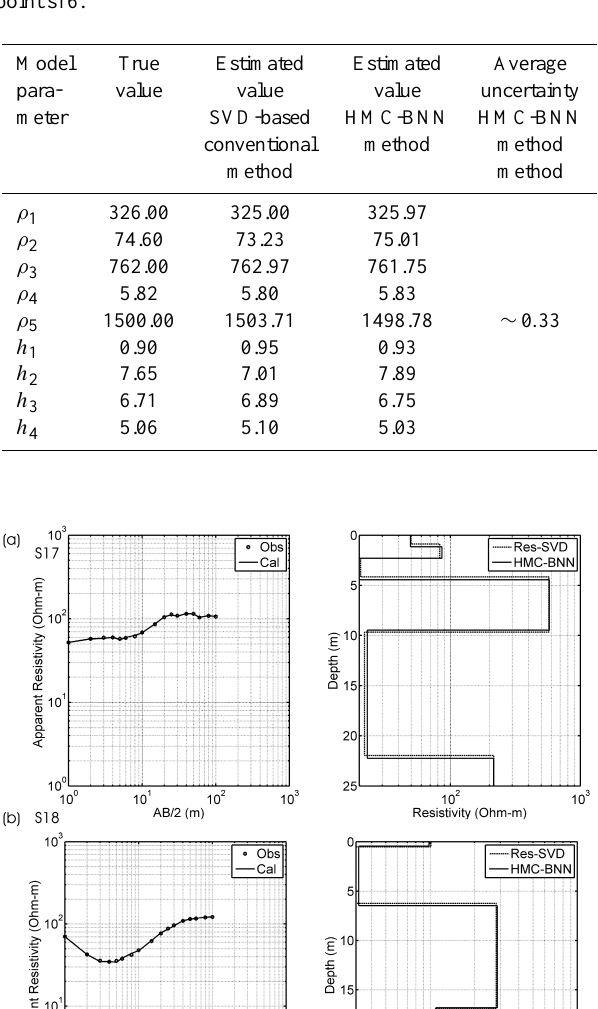
Table 2. Estimation of model parameter of real data of sounding point s16.